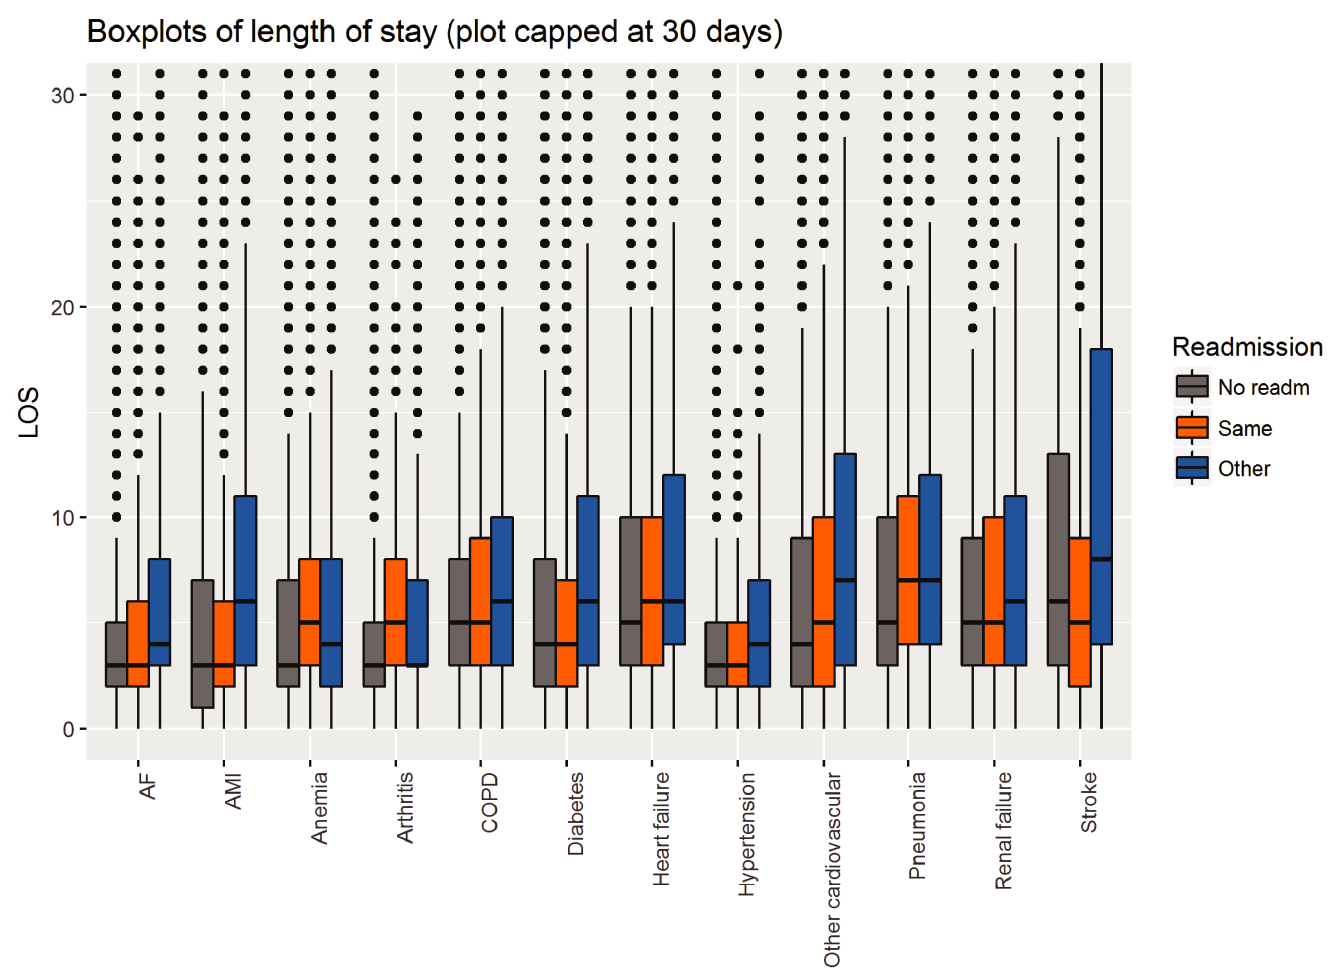
Fig 3. Length of stay (LOS) for the index hospitalisation of the chronic conditions in those that were not readmitted (grey), readmitted with the same condition (orange) and with another condition (blue). Abbreviations: AF atrial fibrillation; AMI acute myocardial infarction; COPD chronic obstructive pulmonary